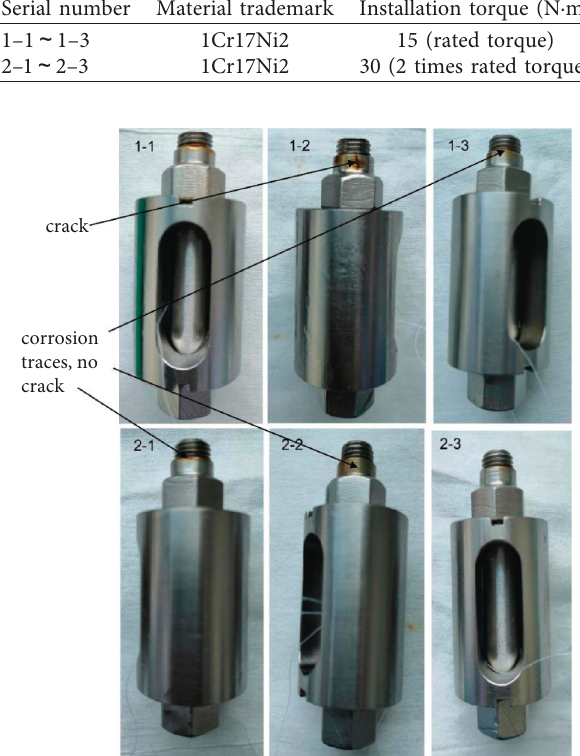
Figure 10: The surface condition of the test piece soaked in boiling magnesium chloride solution for 4h.